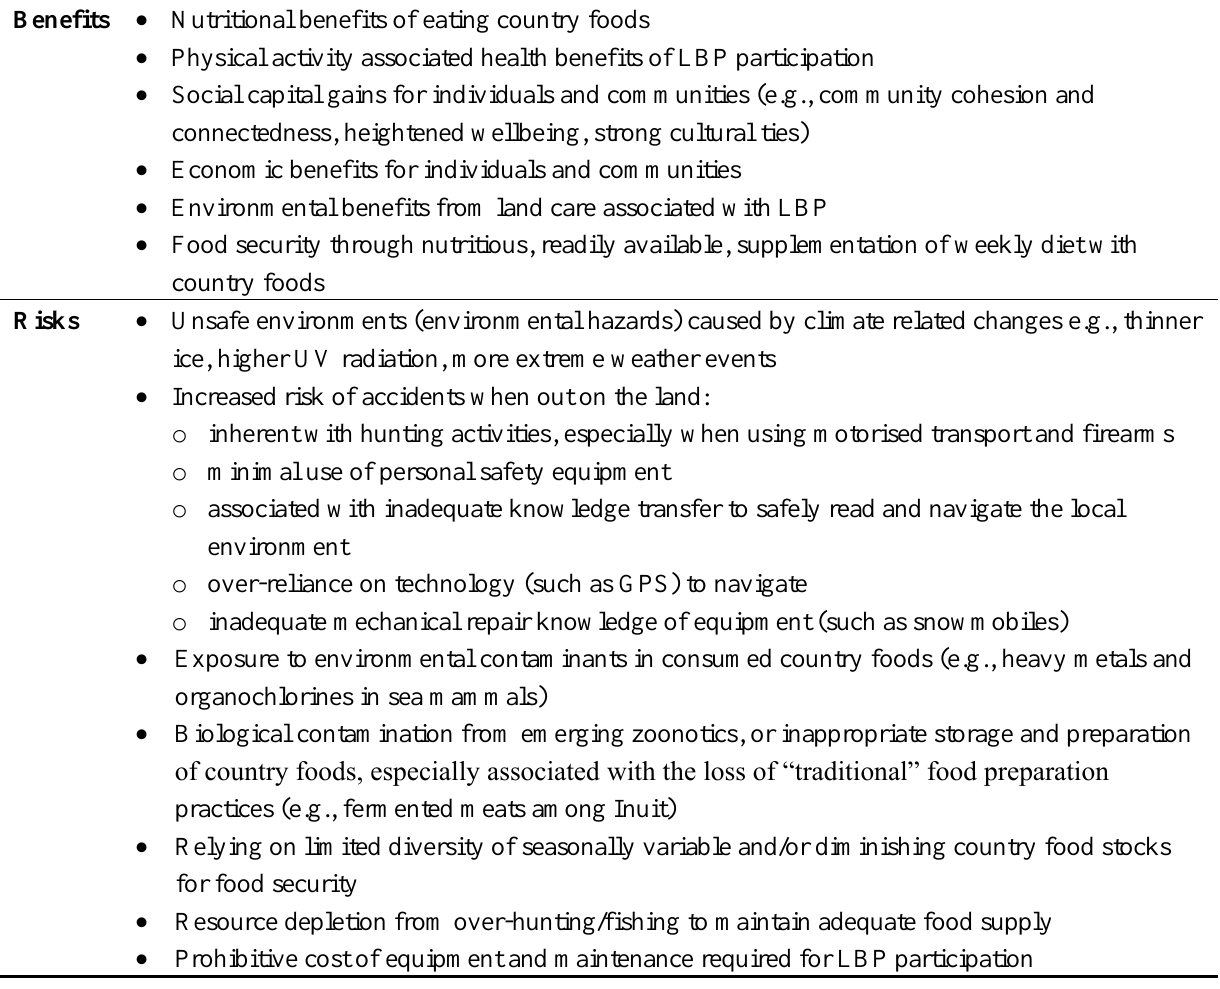
Table 1. Summary of the key benefits and risks of Indigenous participation in hunting/fishing/gathering identified in the reviewed